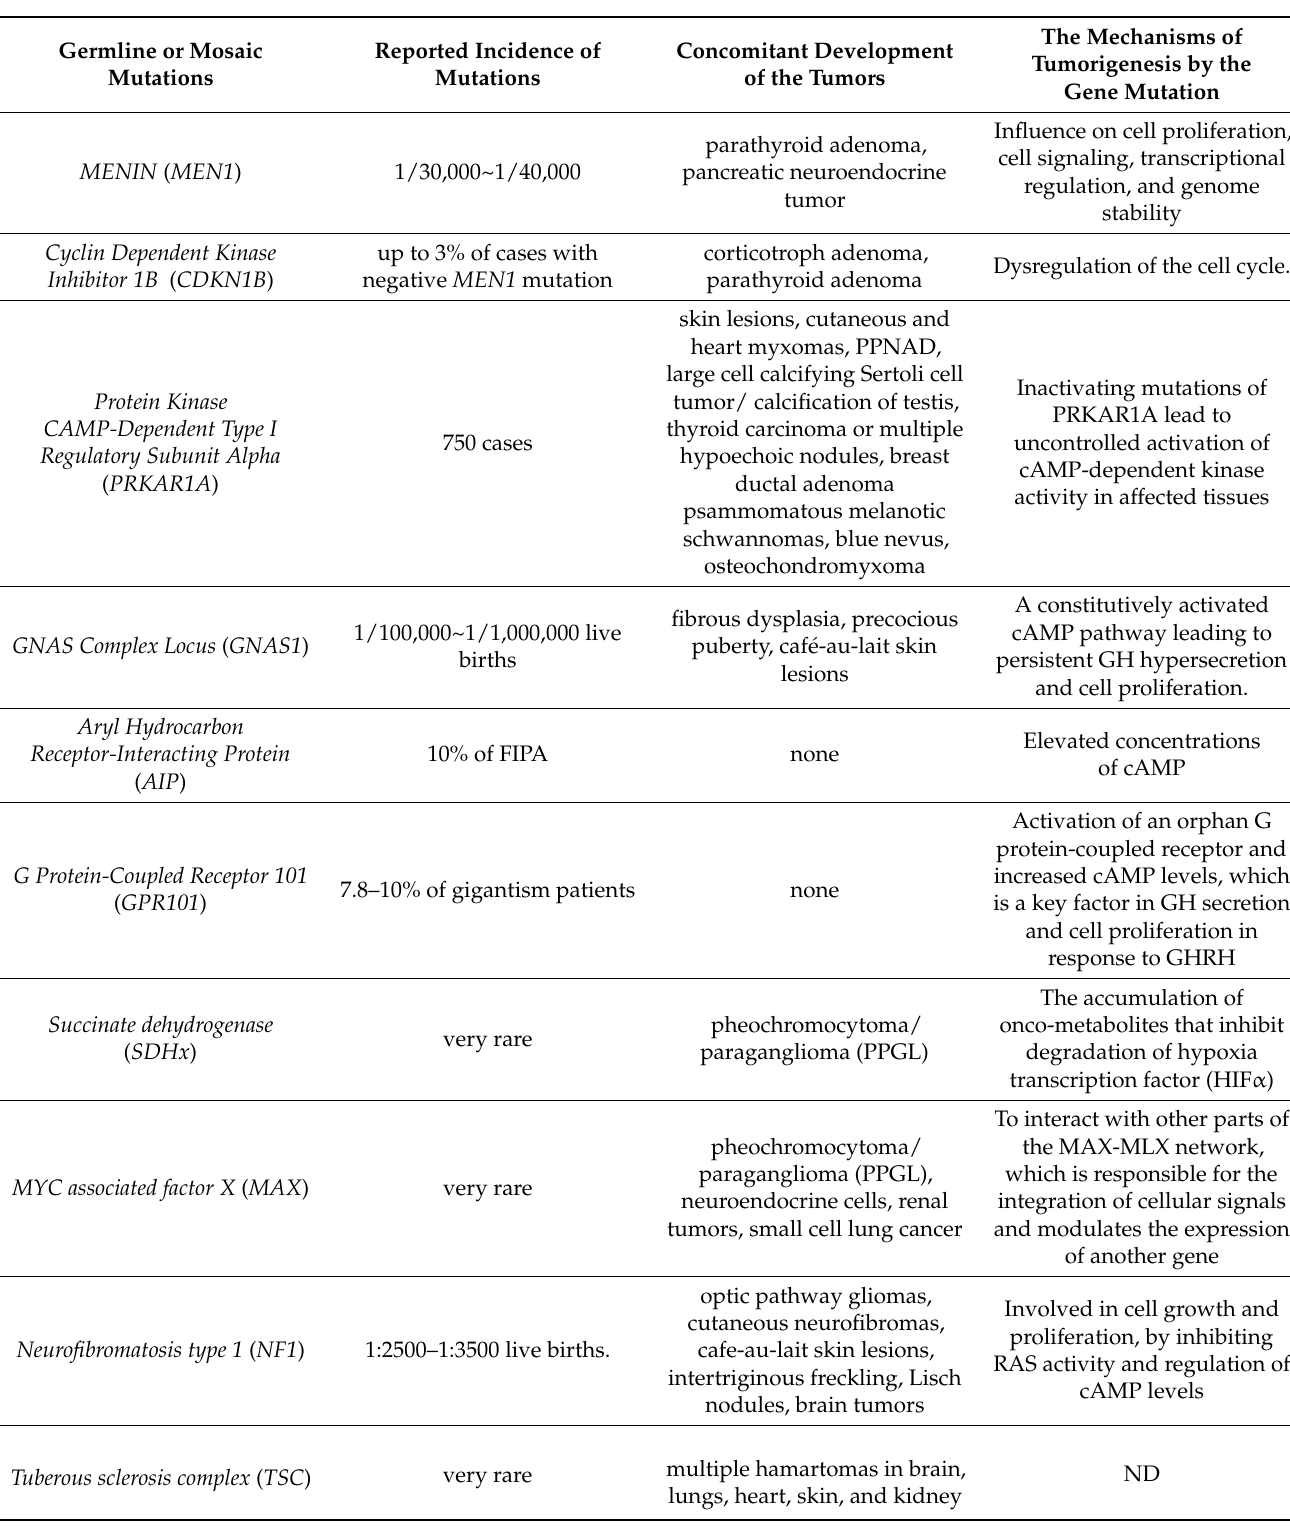
Table 1. The list of disease-related genes that are involved in the pathogenesis of somatotroph tumors. ND: not